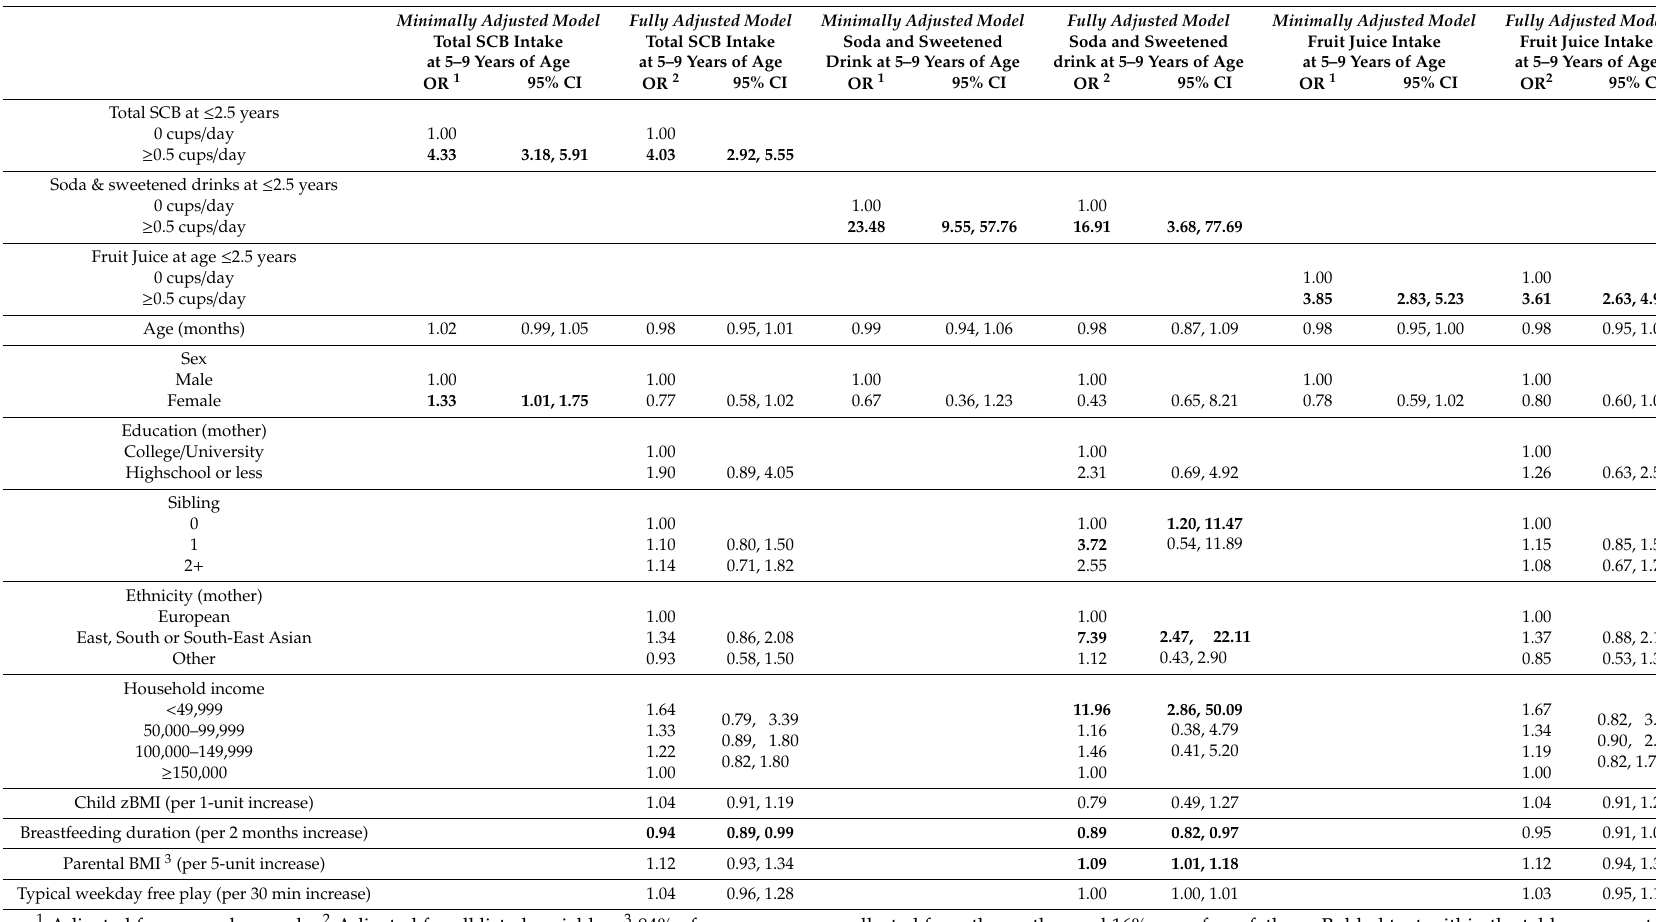
Table 3. Odds ratio estimates for total sugar-containing beverages (SCB), soda and sweetened drinks, and fruit juice intake at 5–9 years of age, for children with a visit at ≤ 2.5 years of age and 5–9 years in the TARGet Kids! Research Network ( n =